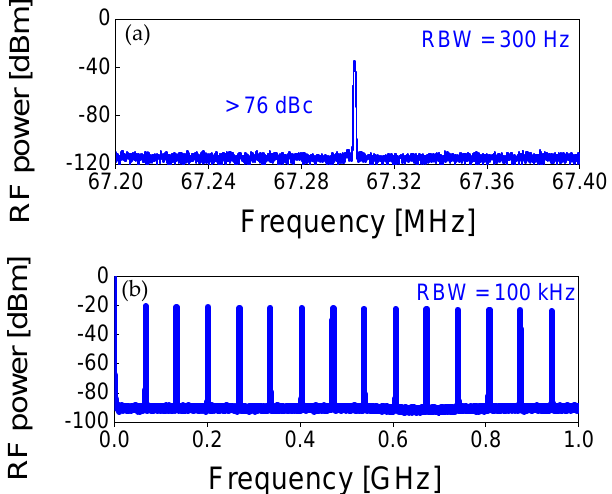
Figure 6. Radio-frequency (RF) spectra of the SESAM ML Yb:GdCB laser: ( a ) fundamental beat note at 67.3 MHz recorded at a resolution bandwidth (RBW) of 300 Hz and ( b ) harmonics on a 1-GHz frequency span, measured with an RBW of 100